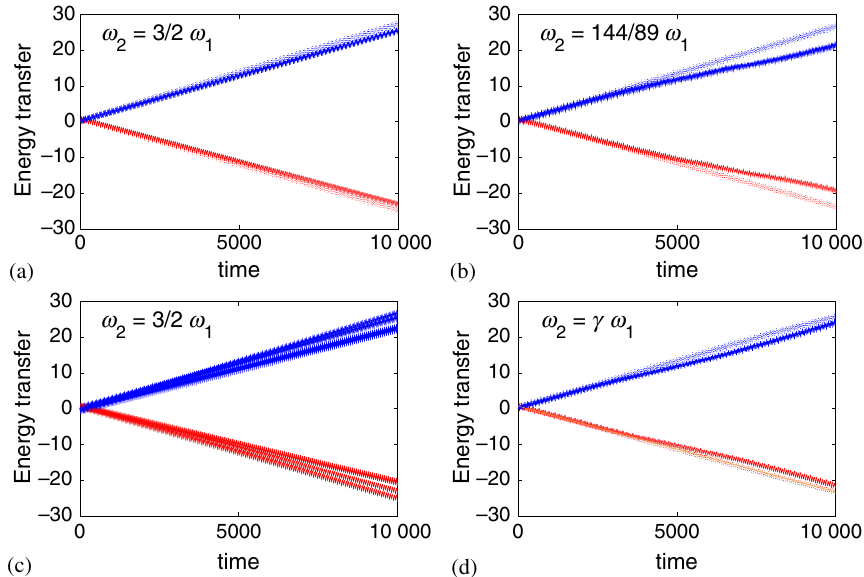
FIG. 10. Comparison of evolution starting from instantaneous (solid lines) and Floquet (dotted lines) eigenstates. Rational frequencies in panels (a) – (c) are approximations of the golden mean γ . The Hamiltonian scale is η ¼ 1 and ω 1 ¼ 0 . 1 , with ω 2 stated on the plots. Panel (c) illustrates how the energy transfer for the rational drive depends on the relative phase, ϕ 2 − ϕ 1 ¼ 0 , 1.5, 3, 4.5, starting from the respective instantaneous eigenstates. The variation is due to sampling of different closed lines in the phase Brillouin zone. Panel (d) illustrates how initializing into a Floquet eigenstate (computed for ω 2 ¼ 144 = 89 ω 1 ) enhances pumping at long times for the irrational